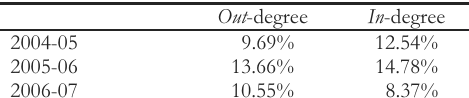
Network centralization measures